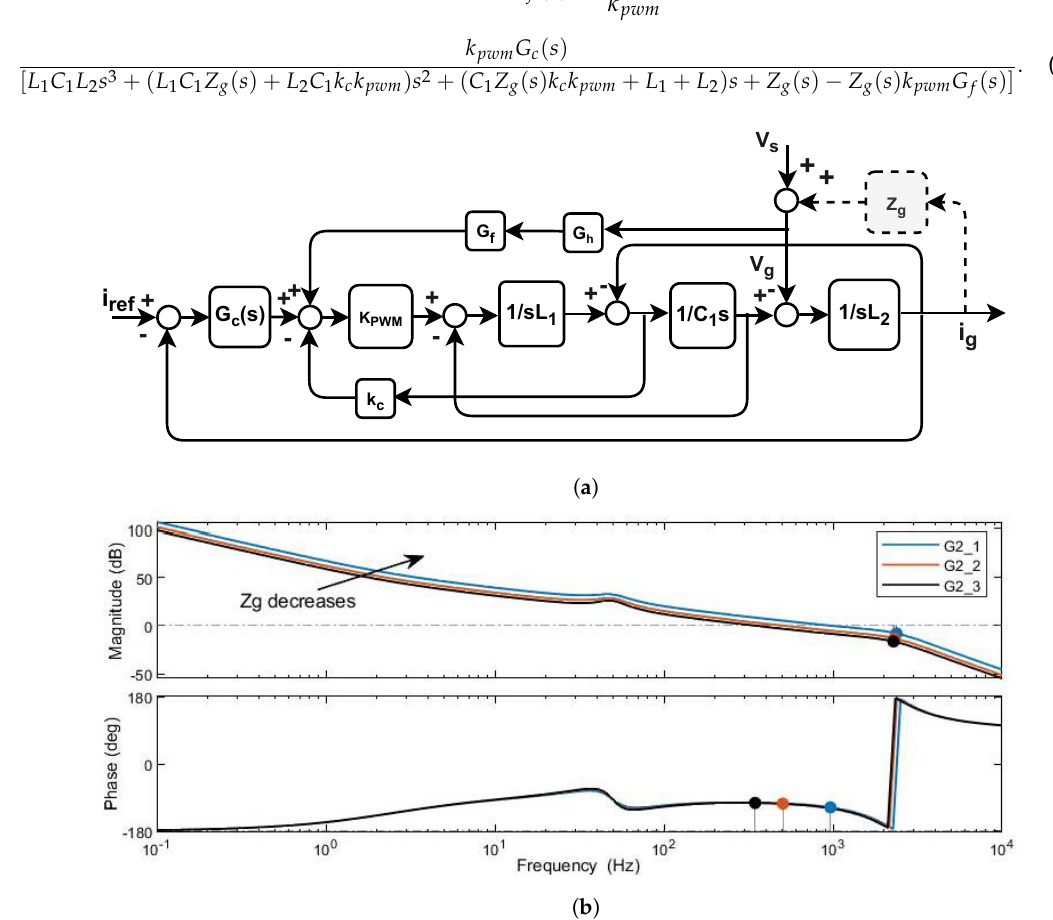
Figure 4. Strategy 2: SOGI based grid voltage feedforward ( a ) Average switch control model. ( b ) Open loop system